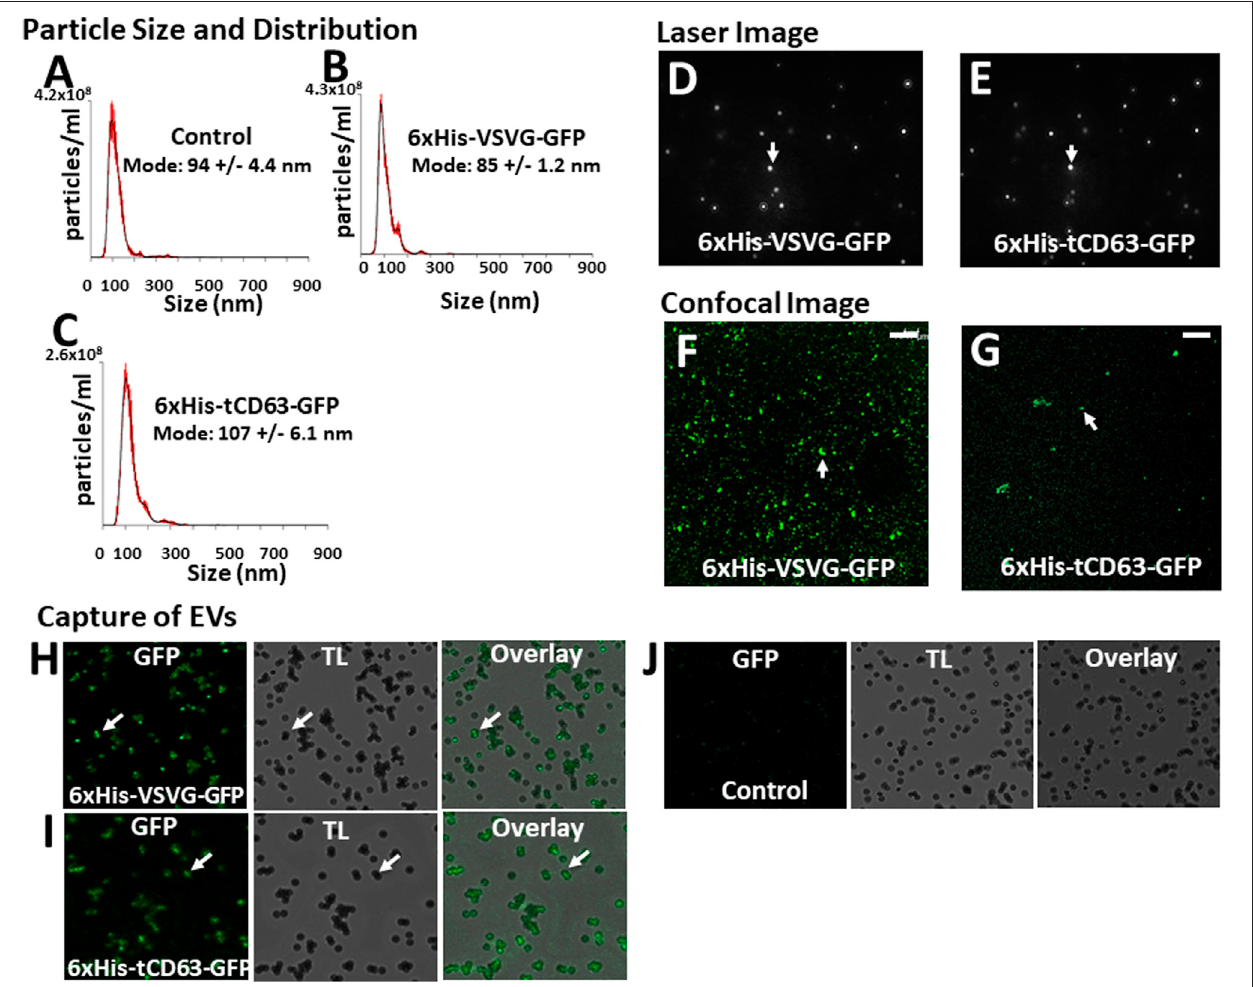
FIGURE4| IsolationandcharacterizationofengineeredEVs.72 hpost-transfectionof293Tcellswitheither6xHis-VSVG-GFPor6xHis-tCD63-GFP-Puro,ornon- transfected controls, EVs were isolated and subjected to nanoparticle tracking analysis (NTA) (A – C) , laser light re fl ecting and Brownian motion analysis (D, E) , and fl uorescent images (F, G) . Af fi nity pull-down of His-tagged EVs using Nickel-coated magnetic beads were conducted and the confocal images of green fl uorescence, transmitted light (TL) and overlay, to show speci fi c capture of 6xHis-VSVG-GFP (H) and 6xHis-tCD63-GFP (I) labelled EVs, but not of non-transfected control EVs (J) . Transmitted light (TL). Scale bar, 10